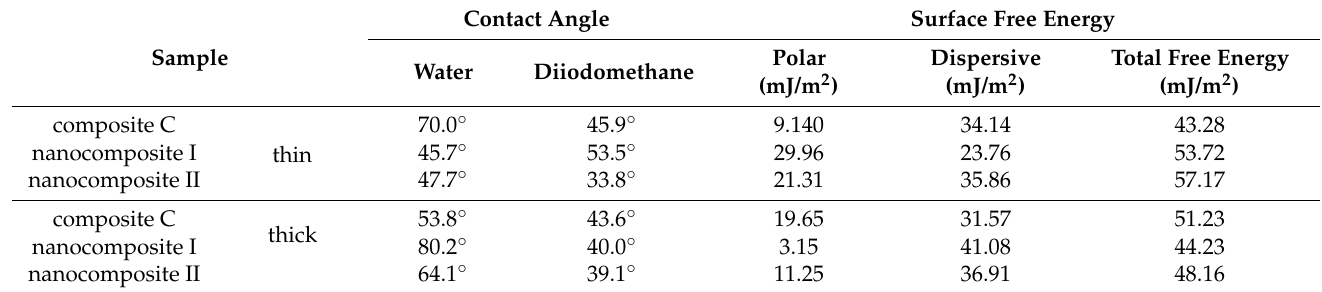
Table 2. Contact angle and surface free energy of the